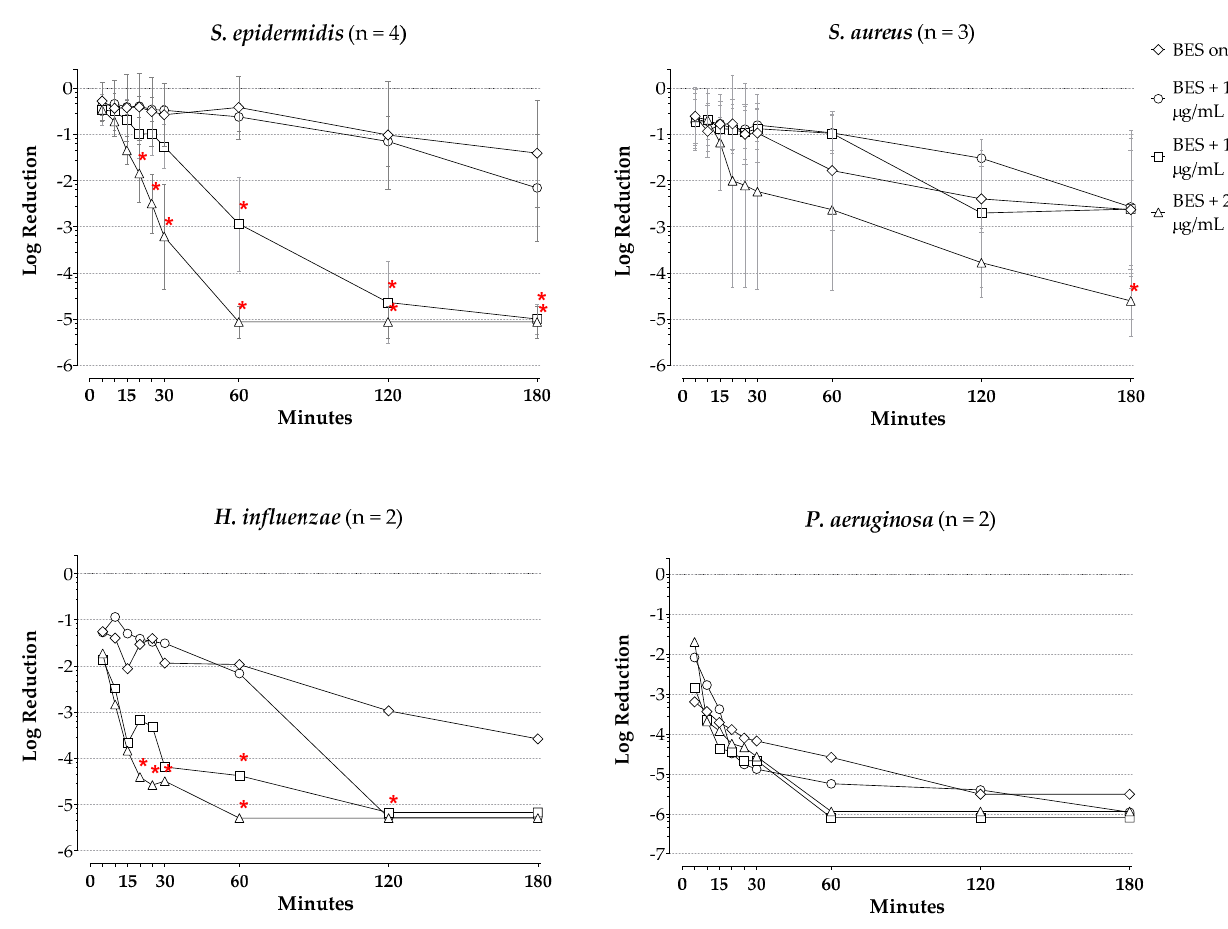
Figure 2. Log reductions in viable cells over time with 100 µg/mL besifloxacin alone or combined with increasing amounts of BAK. Starting (0 min) viable cell densities for each isolate were ~10 5 CFU/mL. Each plot point represents the mean (±SD) ( S. epidermidis and S. aureus ) or average ( H. influenzae and P. aeruginosa ) for the isolates tested of each species. * p < 0.05 compared with besifloxacin. BES = besifloxacin, BAK = benzalkonium chloride.